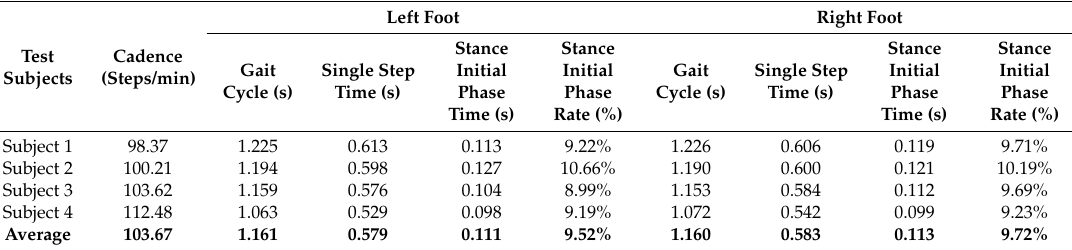
Table 7. Labeled data results of gait temporal